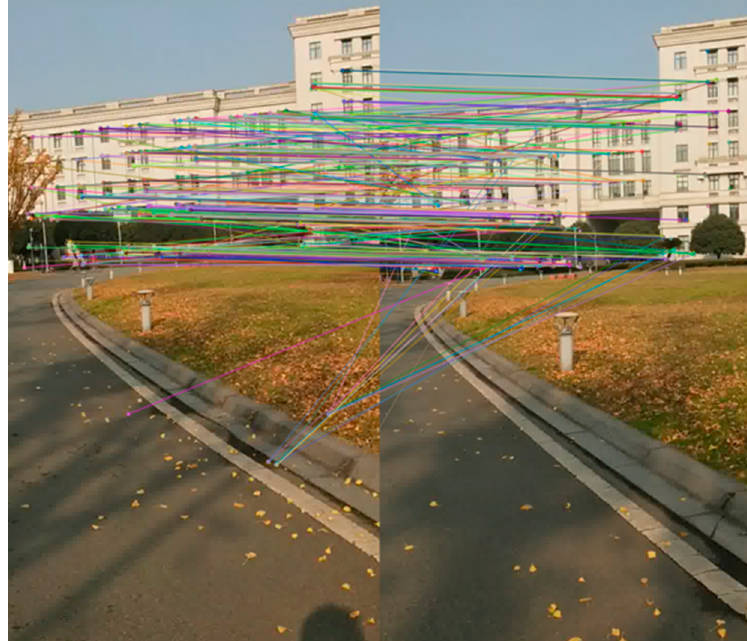
Figure 13. An example of ORB feature matching (no rejection of mismatch).